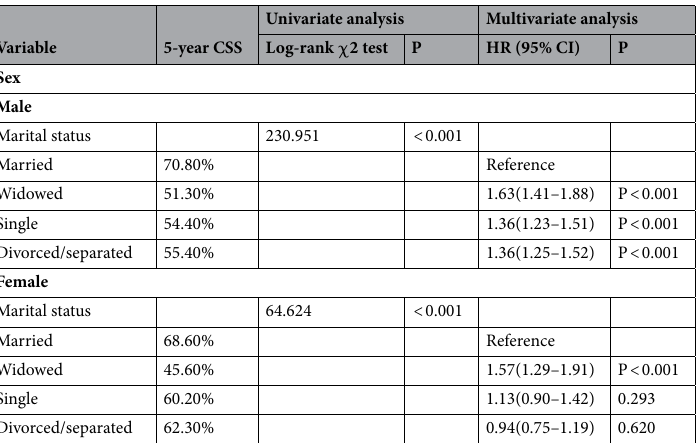
Table 7. Univariate and multivariate analysis of the effect of marital status on laryngeal cancer CSS based on different sex before PSM. CSS, cancer-specific survival; PSM, propensity score matching; HR, hazard ratio; CI, confidence